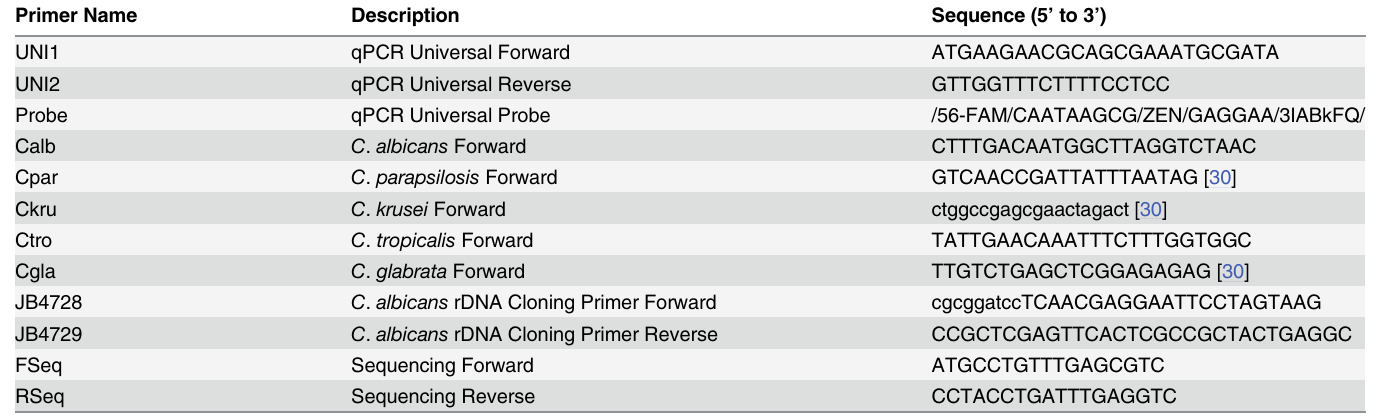
Table 1. Primer and probe